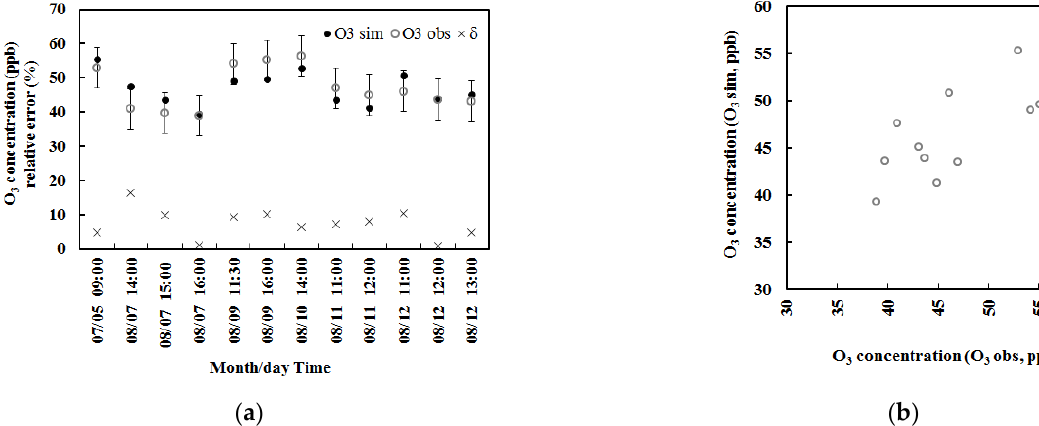
Figure 1. ( a ) The simulated and observed O 3 concentrations (O 3 sim and O 3 obs), with error bars indicating standard deviation of observed O 3 (n = 12) (hereinafter, the same) in a subtropical Pinus plantation in China in 2013, and the relative biases ( δ, % ) (left, situation A, considering isoprene role). ( b ) Scatter plot of O 3 concentrations calculated vs. observed (right, situation A).